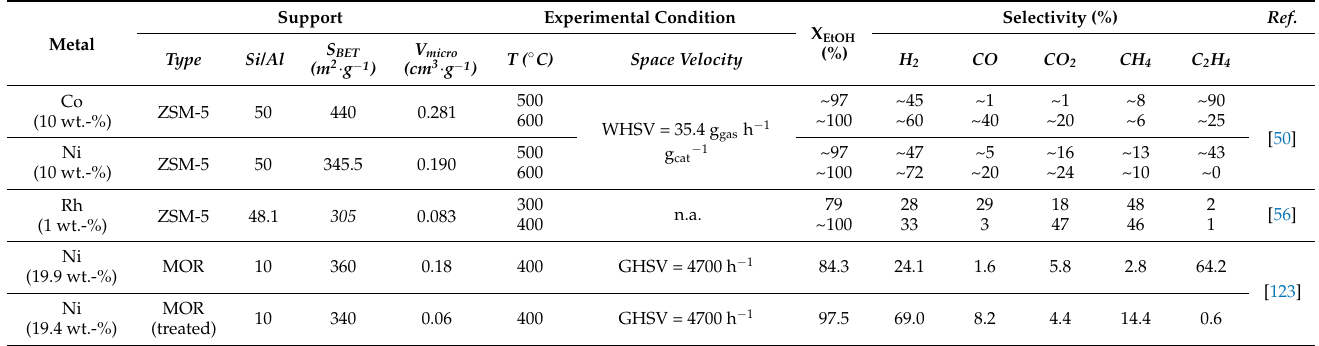
Table 2. ZSM-5 and MOR support for various types of metal catalysts for the ESR